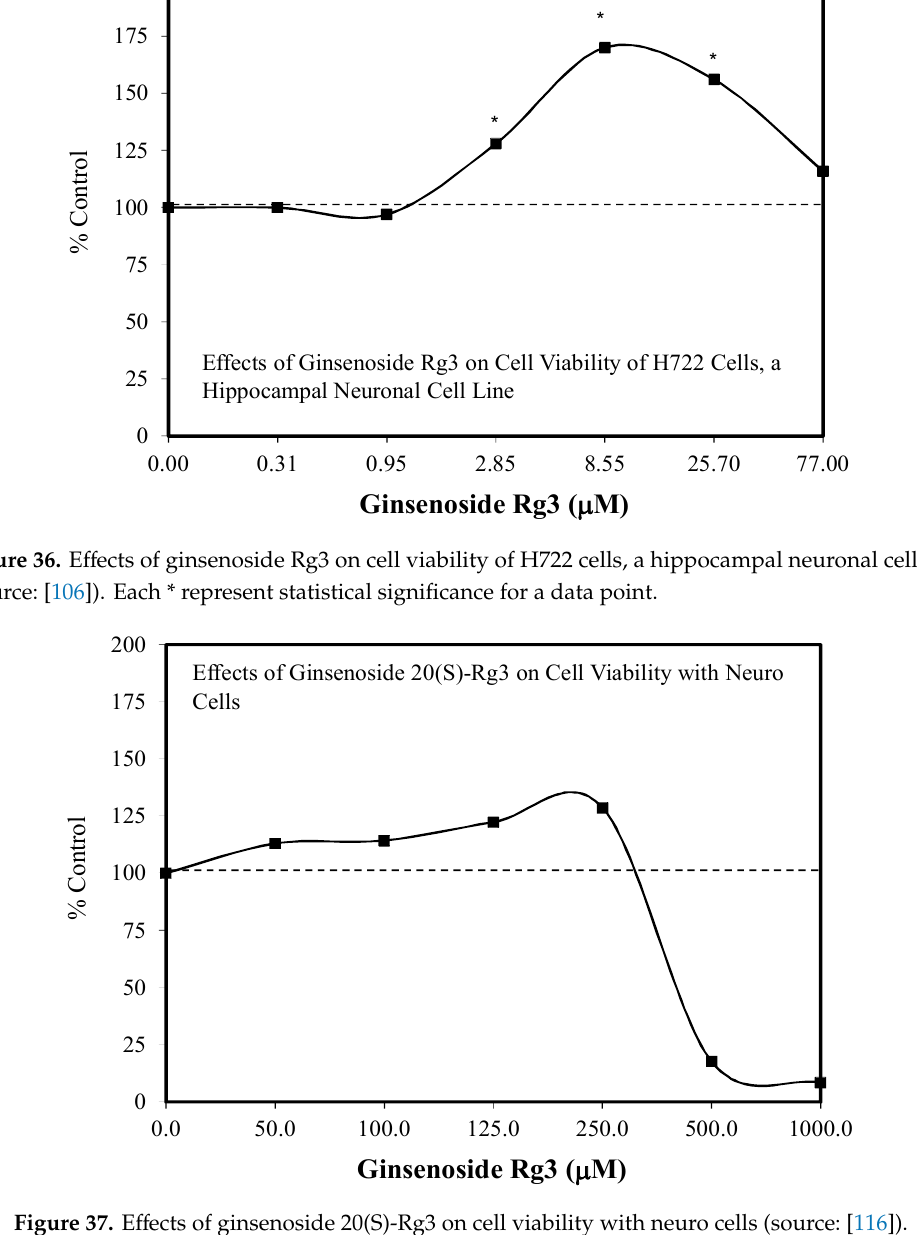
Figure 37. E ff ects of ginsenoside 20(S)-Rg3 on cell viability with neuro cells (source: Figure 37. Effects of ginsenoside 20(S)-Rg3 on cell viability with neuro cells (source: [116]).